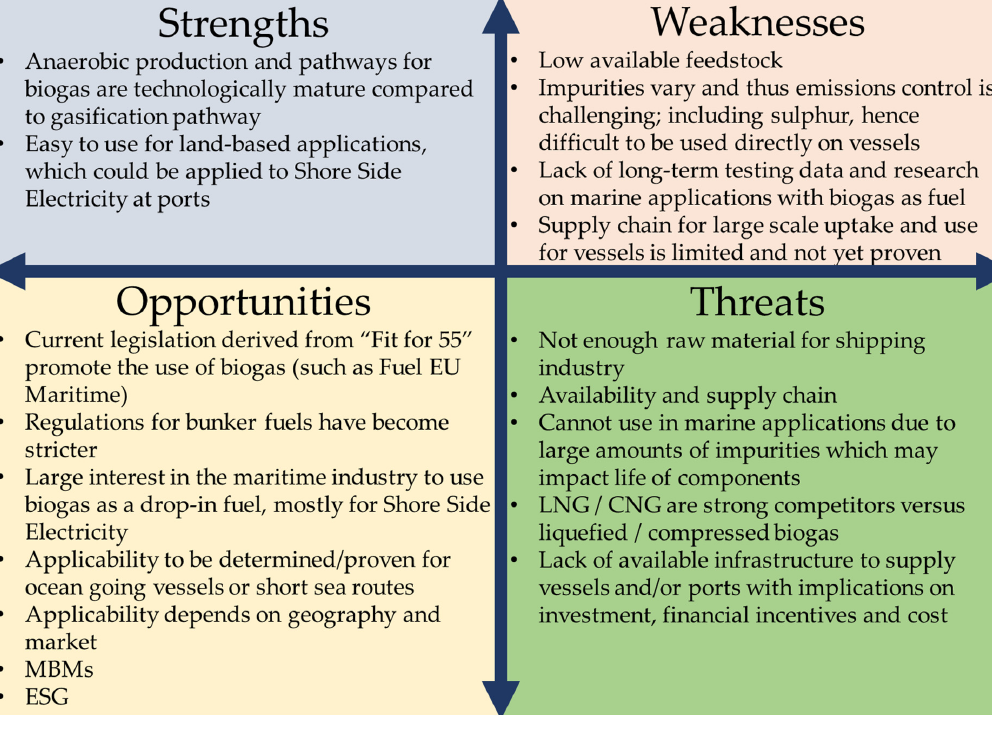
Figure 2. SWOT analysis of biogas.